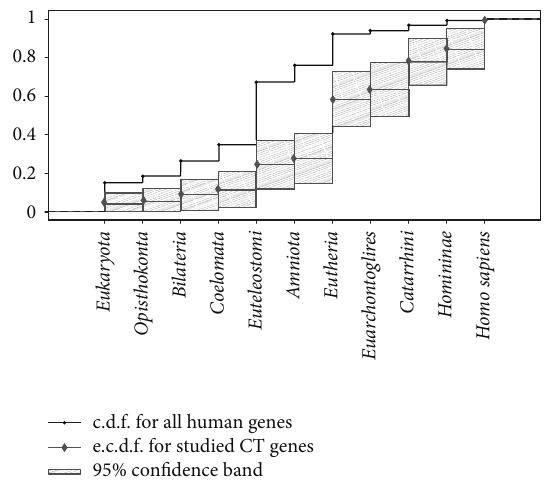
Figure 2: Cumulative distribution function for all human genes and empirical distribution function for all CT human genes, in accordance with the origin of their orthologues in different taxa, with 95% confidence bands. c.d.f.—cumulative distribution func- tion. e.c.d.f.—empirical cumulative distribution function.